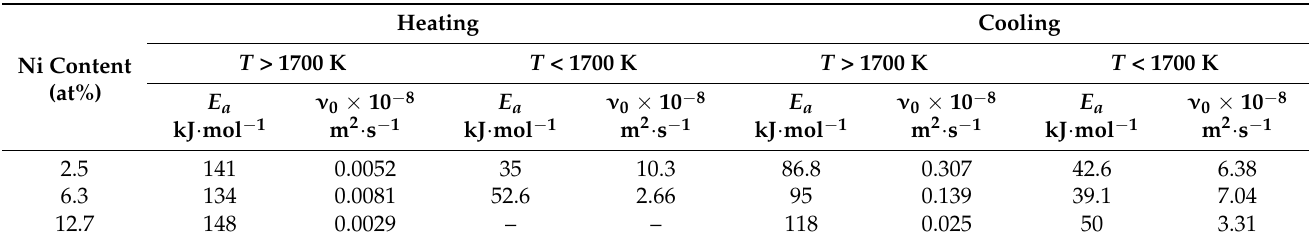
Table 1. Calculated activation energy of viscous flow E a and pre-exponential factor ν 0 in Fe 72.5- x Ni x Cu 1 Nb 2 Mo 1.5 Si 14 B 9 melt for linear sections of Arrhenius